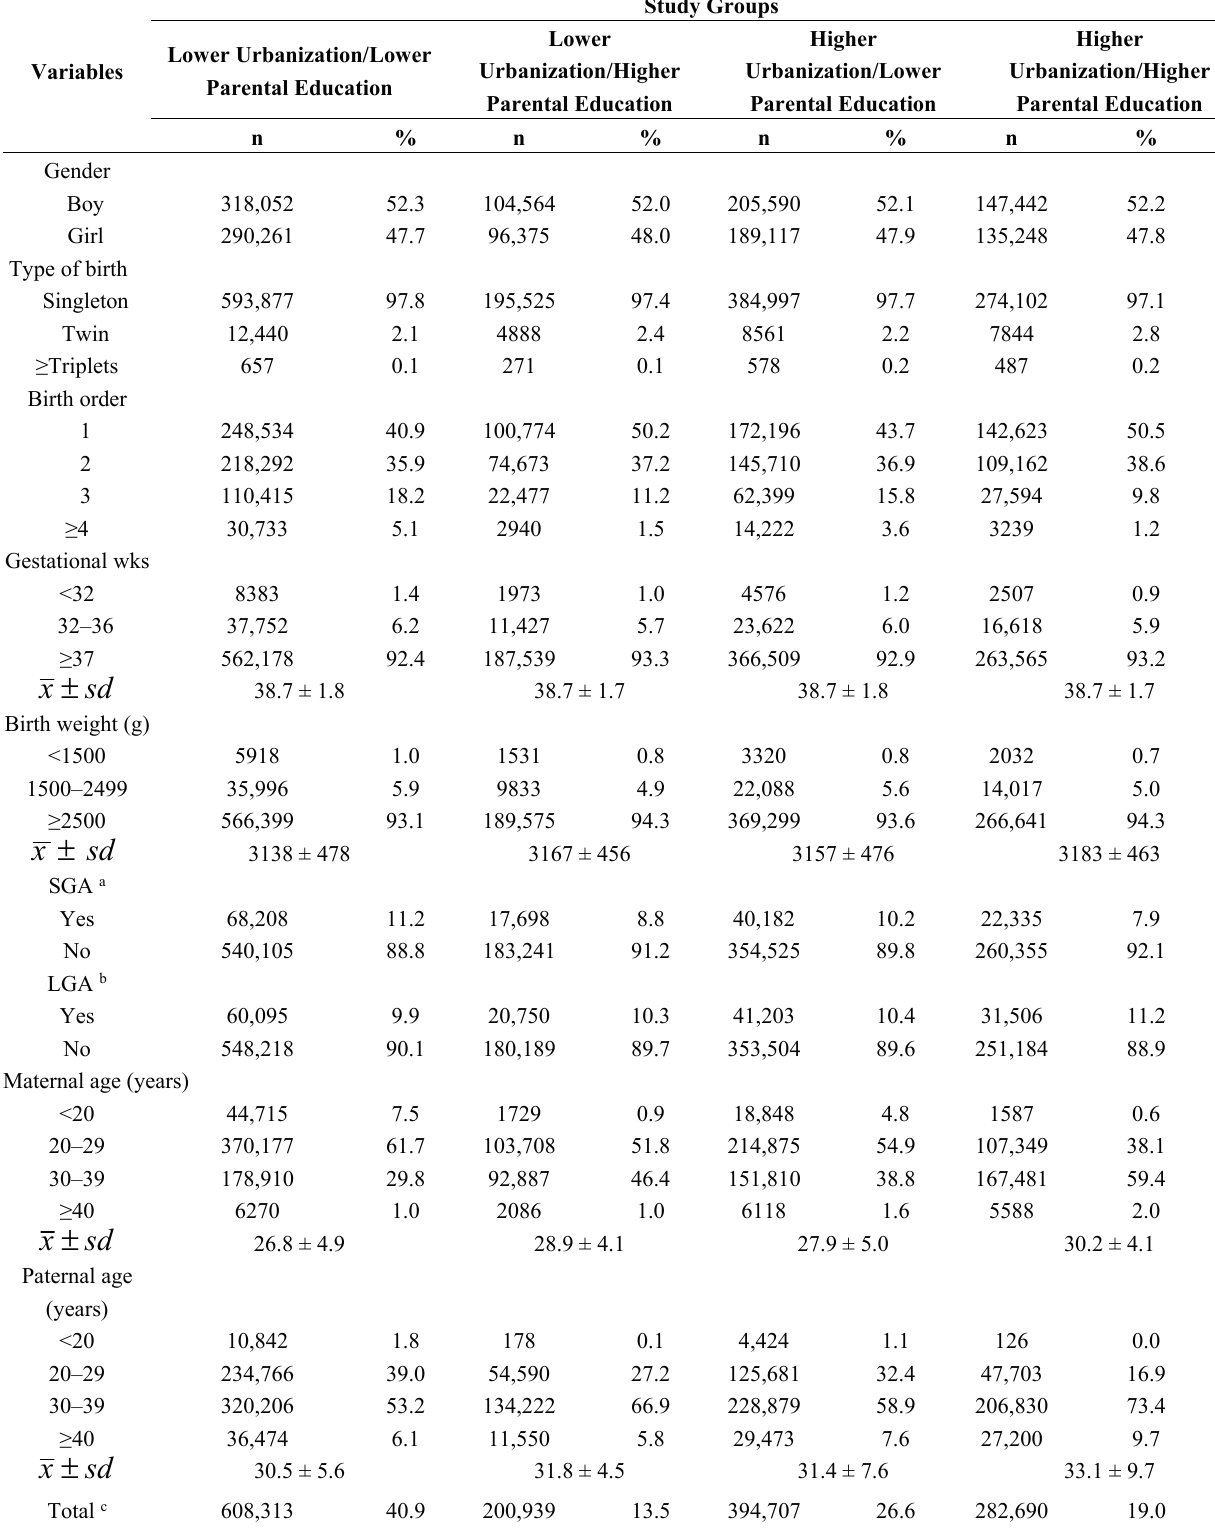
Table 1. Characteristics of the study